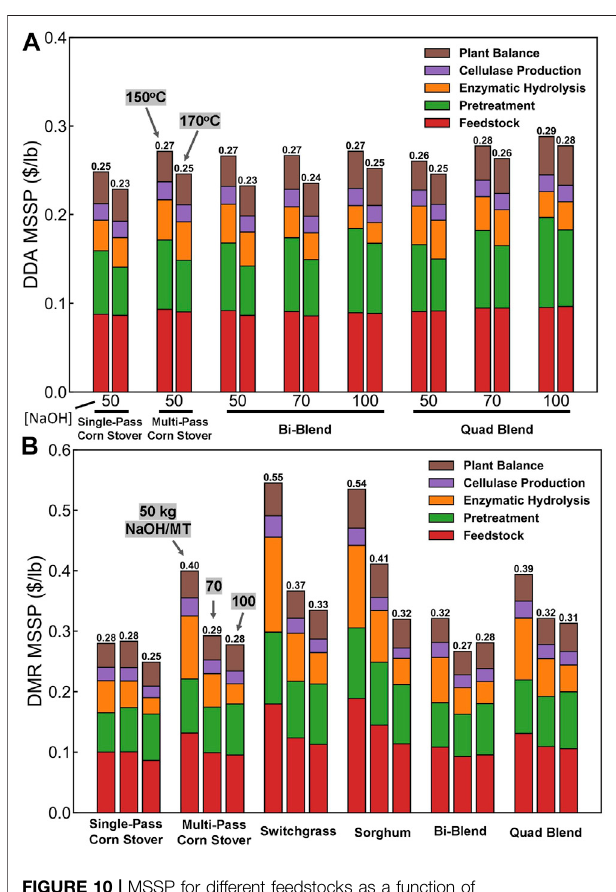
FIGURE 10 | MSSP for different feedstocks as a function of pretreatment technique: (A) DDA and (B)